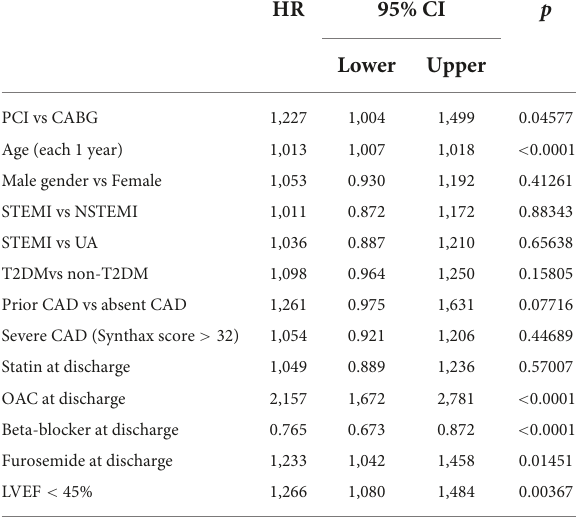
TABLE 2 Cox regression for the occurrence of major adverse cardiovascular events (MACE, cardiovascular death, recurrent hospitalizations due to cardiovascular ischemic events, and incident heart failure New York Heart Association III-IV) as dependent